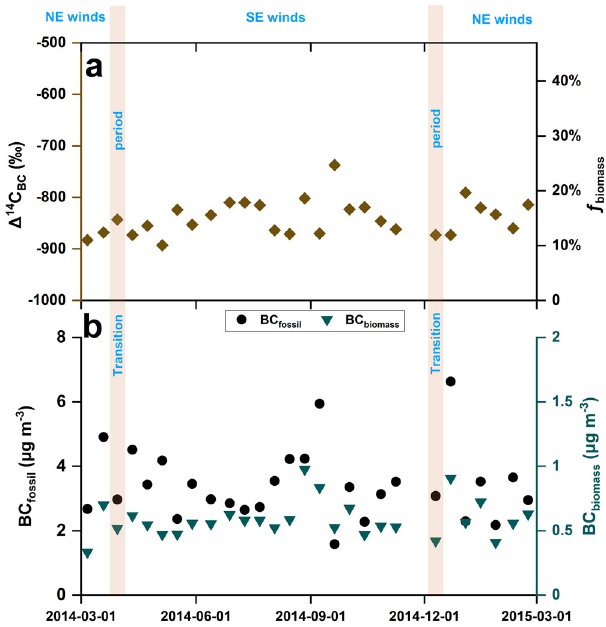
a Presents the Δ 14 C signatures of BC ( Δ 14 C BC ) and the corresponding fractional contribution of biomass burning ( ƒ biomass ), and b shows the Δ 14 C resolved fossil vs biomass sourced BC concentrations in Nairobi. Δ 14 C of − 1000 ‰ implies 100% fossil. Roughly every second sample was analyzed for 14 C signatures. The prevailing are masses received in Nairobi, and the transition periods are